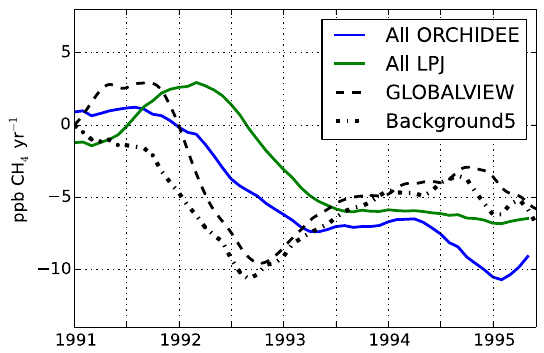
Figure 4. The explained CH 4 growth rate variability in the model using two wetland CH 4 emission inventories, and global deseason- alised CH 4 growth rate differences with respect to 1990 from the GLOBALVIEW observations, and from observations at five back- ground